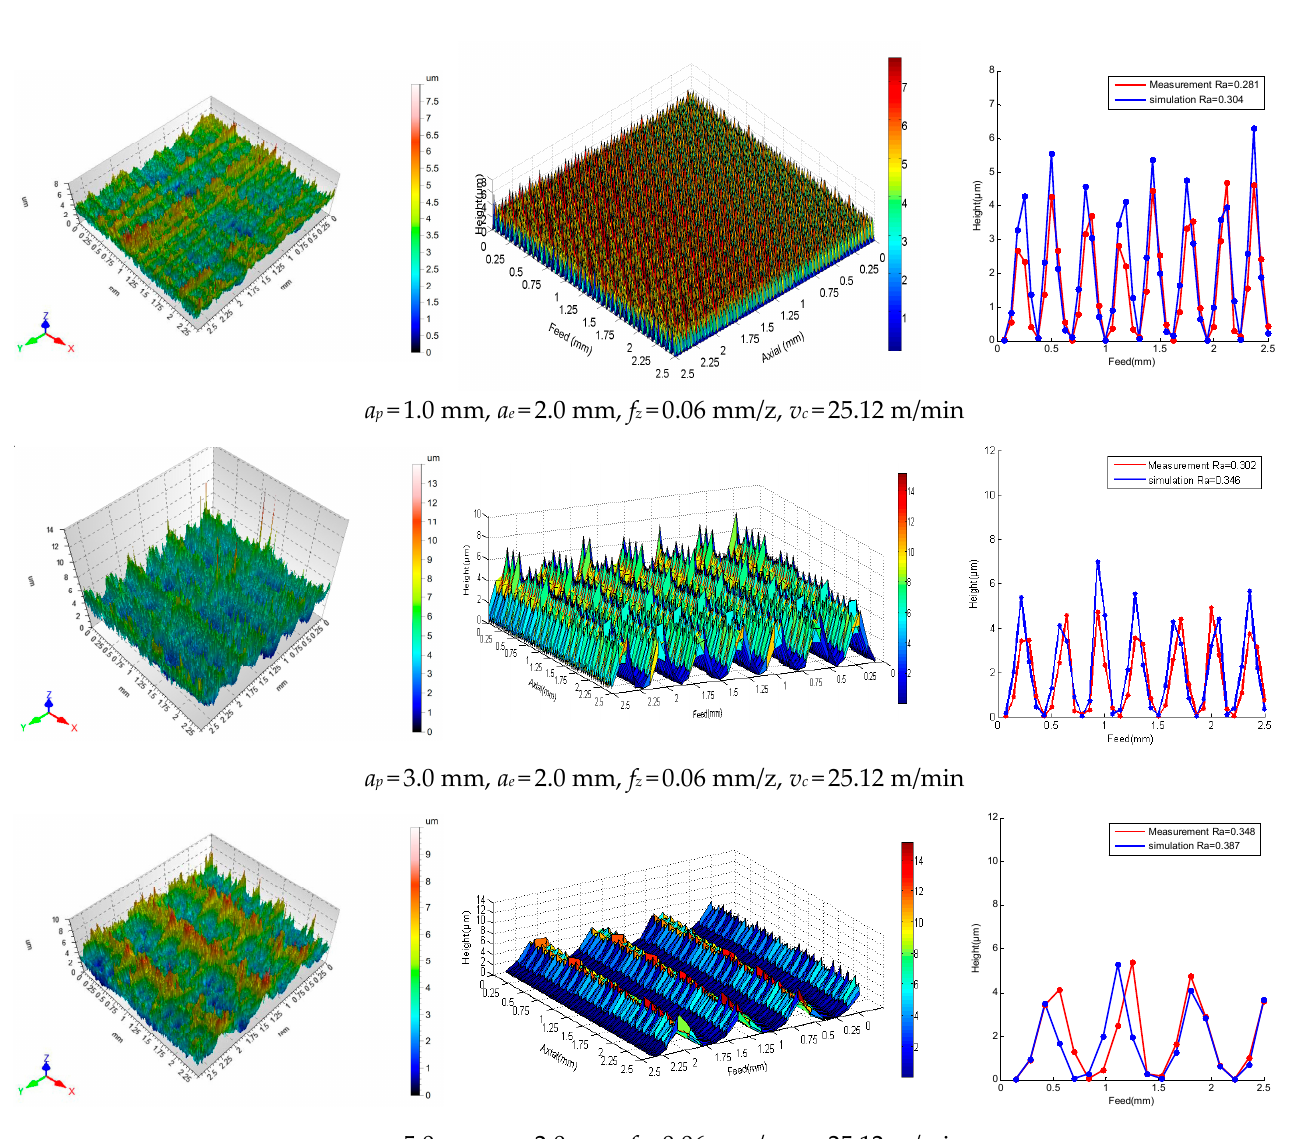
Figure 17. Surface topography of different axial radial milling depths.